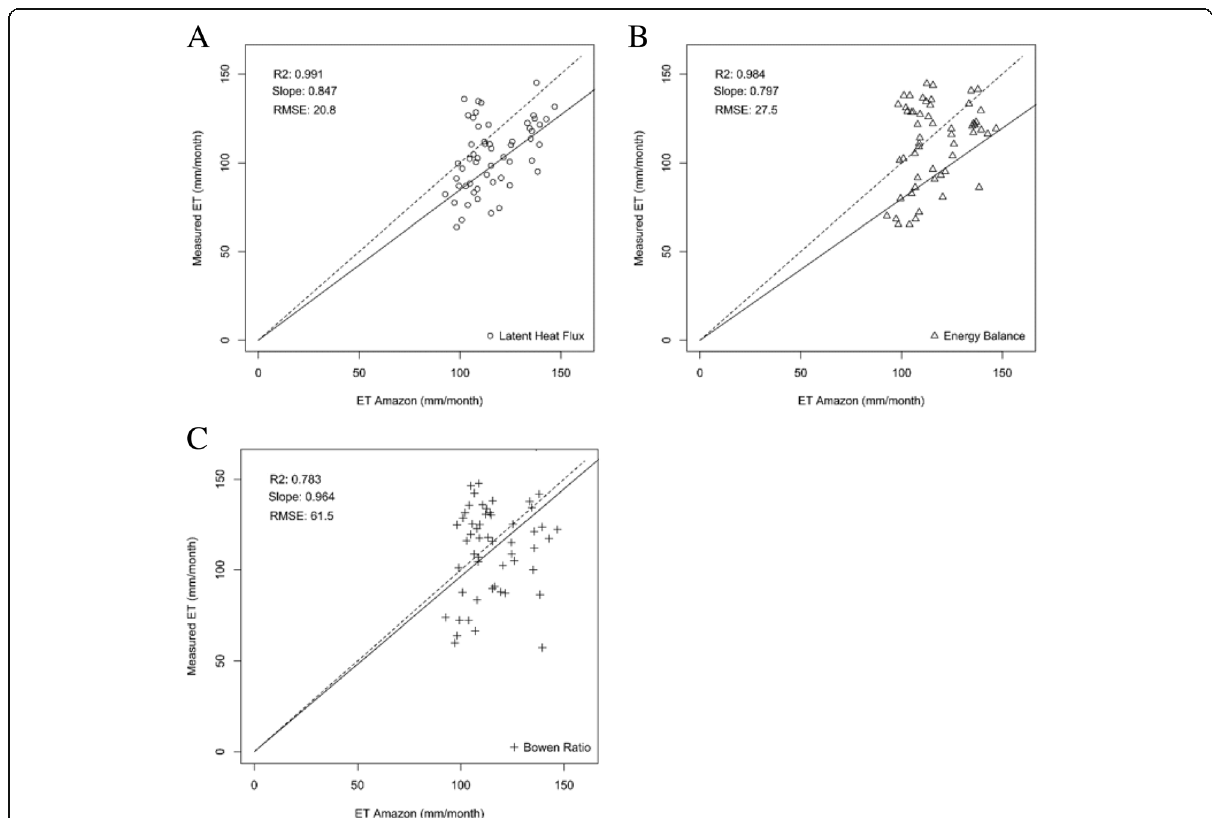
Fig. 5 Scatter diagram of ET measured monthly at five flux towers, plotted against ET-Amazon from six global energy balance products and the three ET methods: (1) direct measurements ( a ), (2) the residual of energy balance ( b ), and (3) the Bowen ratio ( c ). The one-to-one line (dashed) and the trend line (solid) are also shown